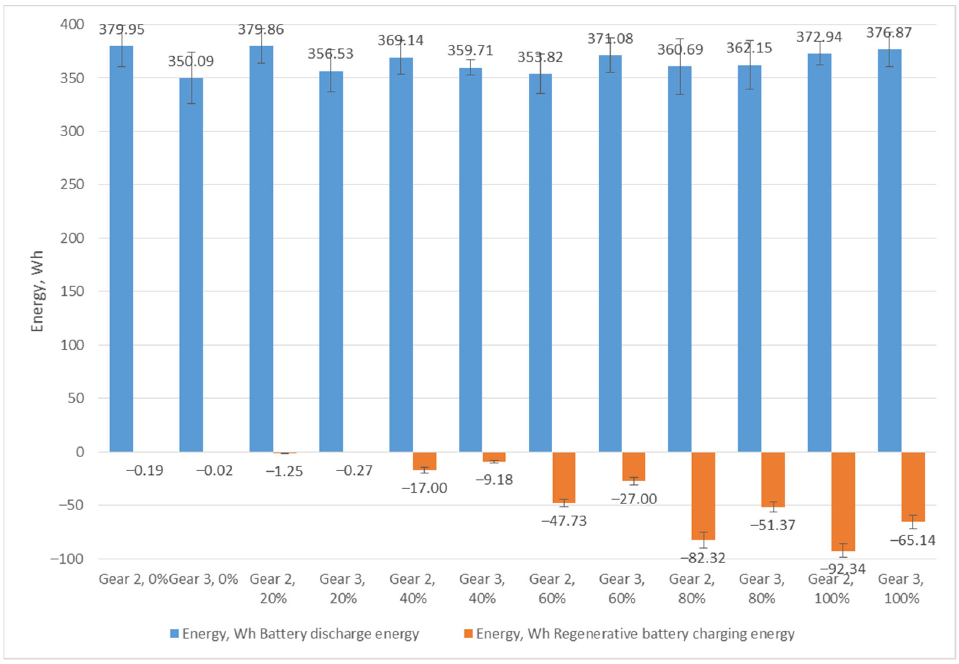
Figure 6. Maximum current when accelerating and applying regenerative braking.